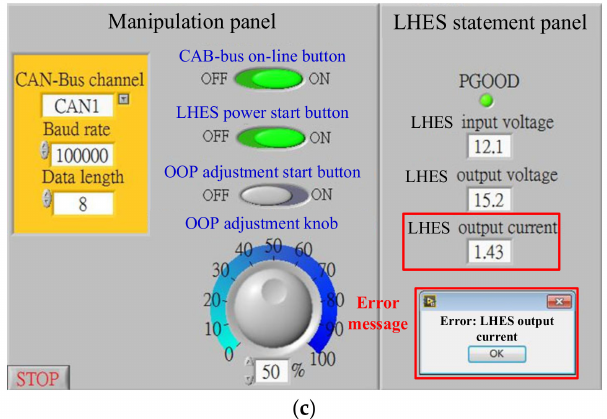
Figure 22. Human–machine interface manipulation and motoring. ( a ) Input voltage, ( b ) output voltage and ( c ) output current